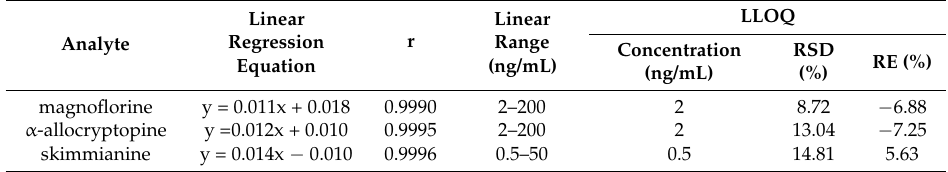
Figure 6. The typical SRM chromatograms. 1 . Blank plasma; 2 . Blank plasma spiked with three analytes at LLOQ level and IS; 3 . Plasma collected at 1 h after oral administration of Z. nitidum decoction. A . Magnoflorine, B . α -allocryptopine, C . Skimmianine and D . internal standard (IS). Table 2. Regression equation, correlation coefficients, linear range and lower limit of quantification (LLOQ) of analytes.